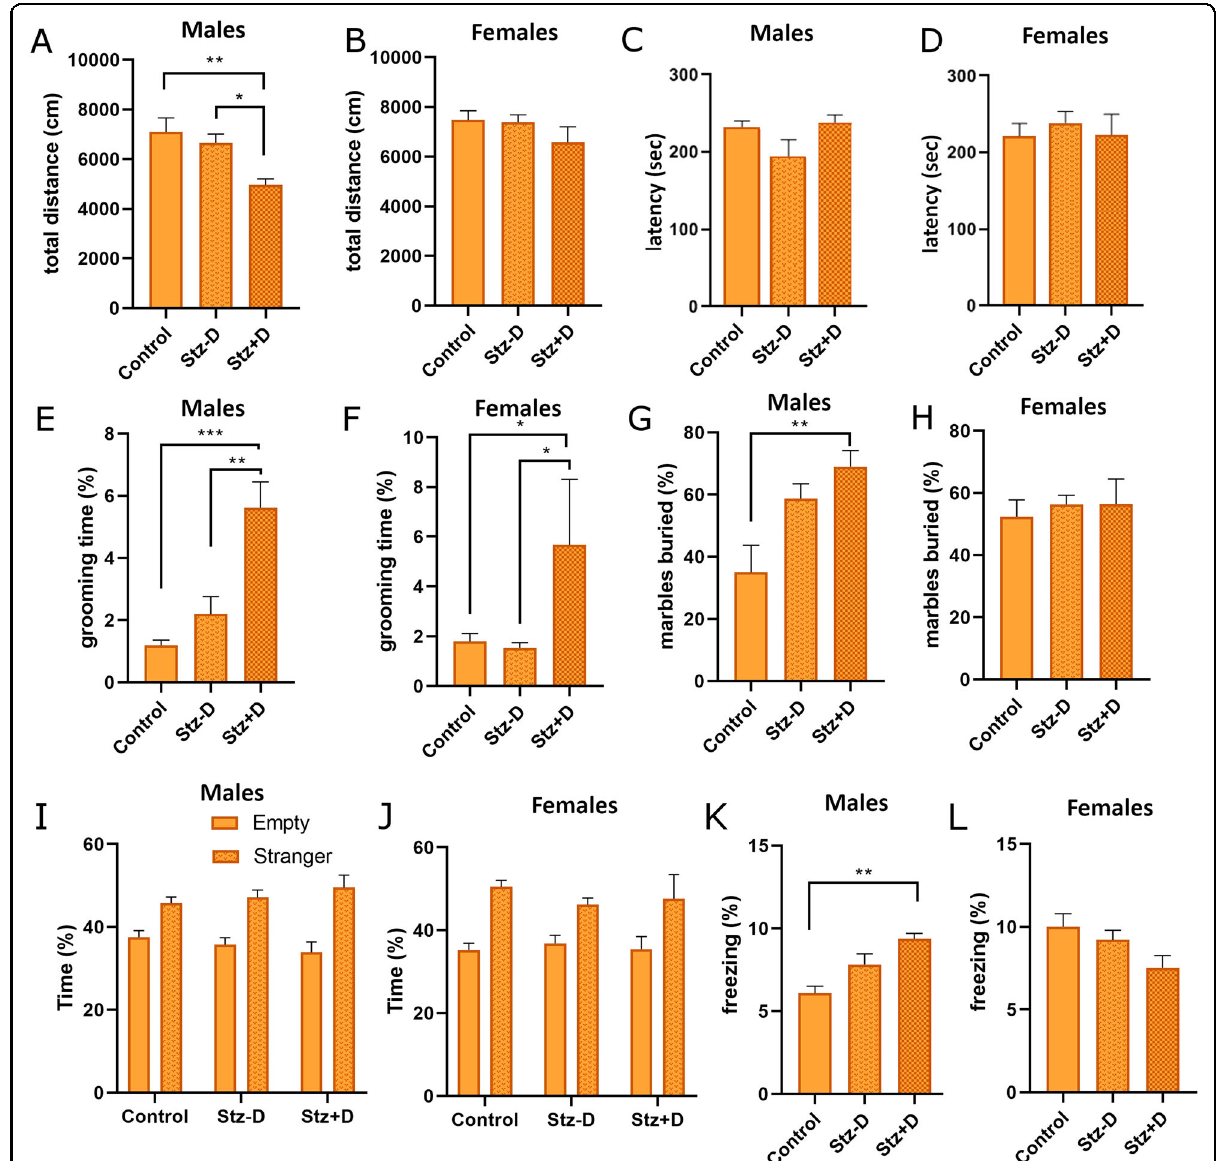
Fig. 3 Effects of Gestational diabetes on behavior. Total distance traveled in the open fi eld test in male ( A ) and female ( B ) mice shows less distance traveled speci fi cally in the male STZ + D mice. Rotarod tests shows no differences in locomotor abilities in all experimental groups in both male ( C ) and female ( D ) mice. Grooming time was calculated in all experimental groups during a 10-minute period in the open fi eld maze. There is a signi fi cant increase in grooming time in the STZ + D group of both male ( E ) and female ( F ) mice. Mice were subjected to a 30-min period in open chamber with 20 marbles. Number of buried marbles were counted. STZ + D group showed signi fi cant increase in buried marbles, compared to control group in the male mice ( G ). No differences are seen in the female mice ( H ). Data are presented as mean ± standard error of the mean. I , J Mice were subjected to the three chambered social interaction test. All experimental groups displayed normal preference toward stranger mice compared to an empty chamber in both male ( I ) and female ( J ) mice. K , L Cue Fear conditioning test was carried out in all experimental groups. In male mice ( K ), STZ + D mice display signi fi cantly more freezing, compared to control mice. There were no differences between groups in female mice. Data are presented as mean ± standard error of the mean. One way Anova. * p < 0.05 n = 10 –